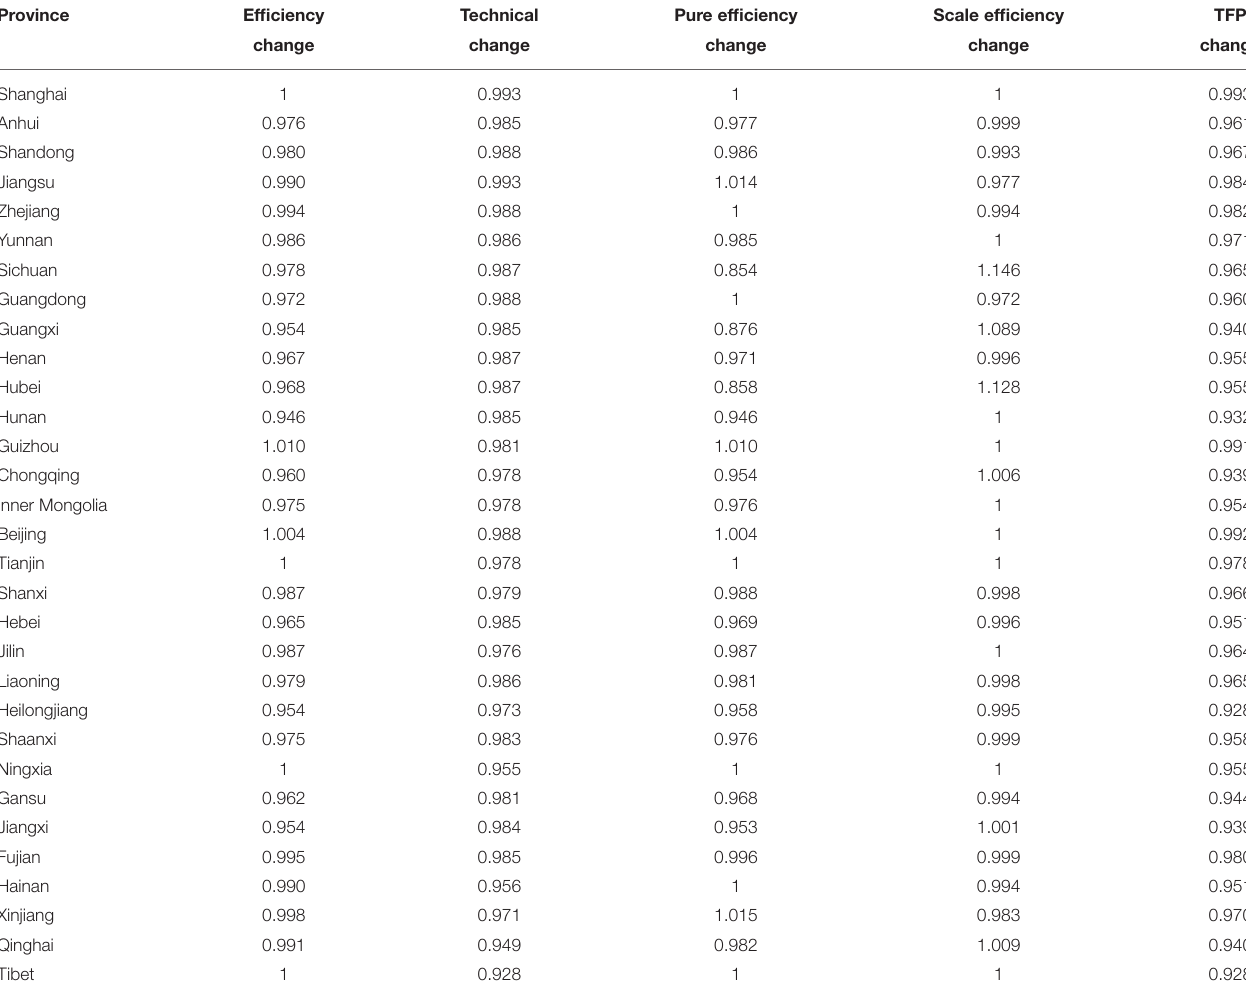
TABLE 2 | Malmquist index summary of province means.